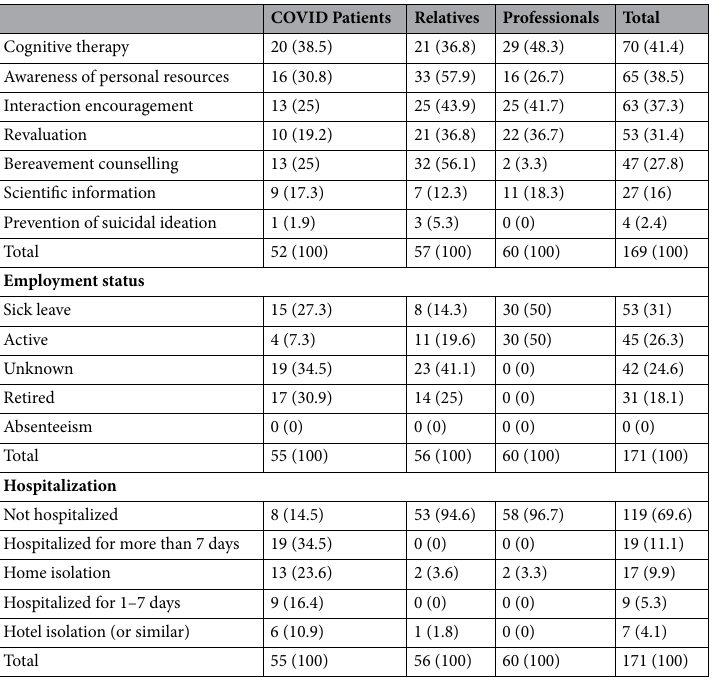
Table 1. User category and employment status, admission, relatives, symptoms, emotions, evolution and intervention. Percentages in parentheses. Data by admission criteria. The absolute numbers, as well as the percentages, are shown in the table for each type of beneficiary of the program. In this way, the evolution, and emotions of each type of user, the symptoms and interventions, their employment status and whether they have required hospitalization can be observed. Similarly, the table shows whether these users also had affected relatives and what condition they are in.